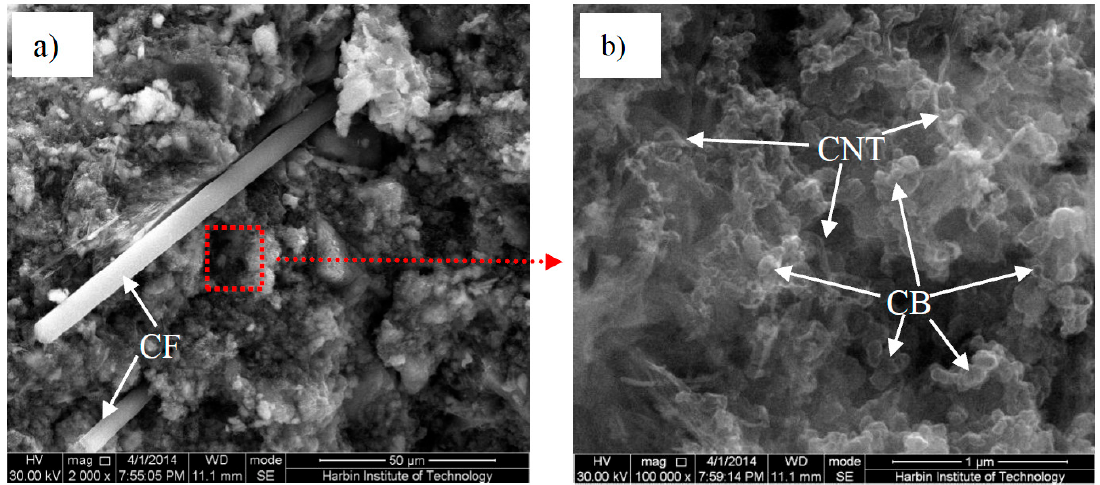
Figure 7. SEM image of a triple carbon-modified cement matrix: ( a ) Carbon fibres at 2000 magnification; and ( b ) CNTs and CB at 100,000 magnification (adapted from [199]).